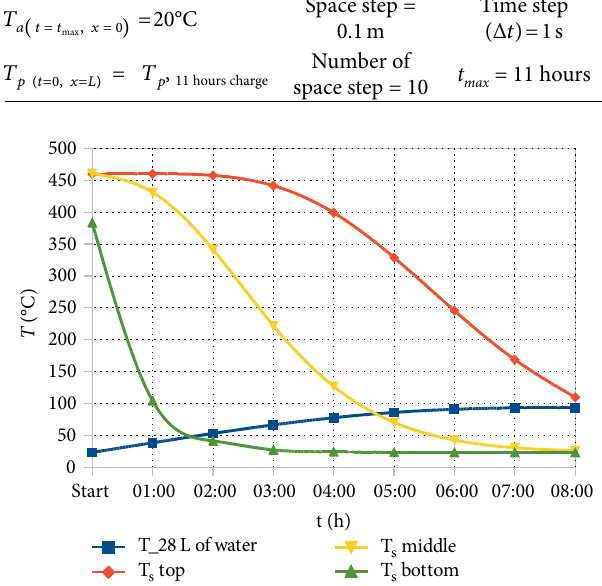
Table 5: Initial and boundary conditions for discharging process.